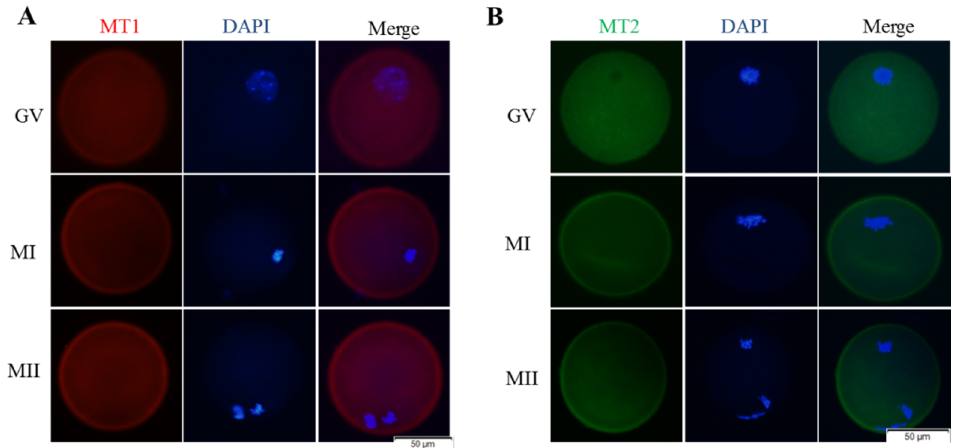
Figure 4. Cellular localization of MT1 and MT2 during maturation of GV oocytes. ( A ) Images of MT1 receptor (red); ( B ) Images of MT2 receptor (green). Notes: GV: germinal vesicle stage, MI: metaphase I, MII: metaphase II.